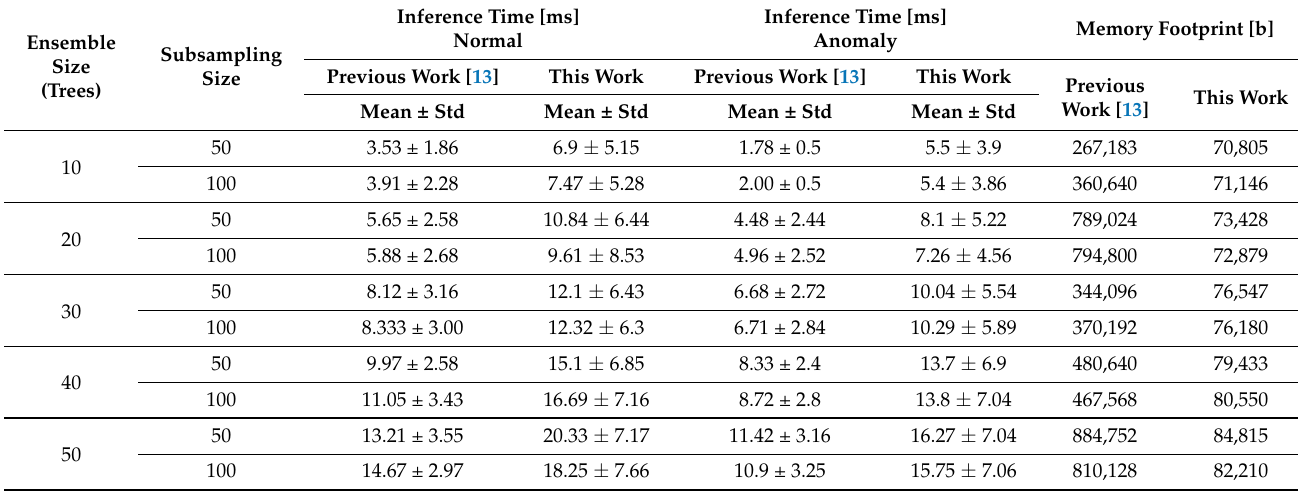
Table 2. Comparison between our previous work ([13]) vs. this work of the performance of the IoT Kit in Inference Mode with different sizes of the IF ensemble, different sizes of the subsampling pool, and detection threshold set to 0.75. Values A ± B show the mean (A) and the standard deviation (B).